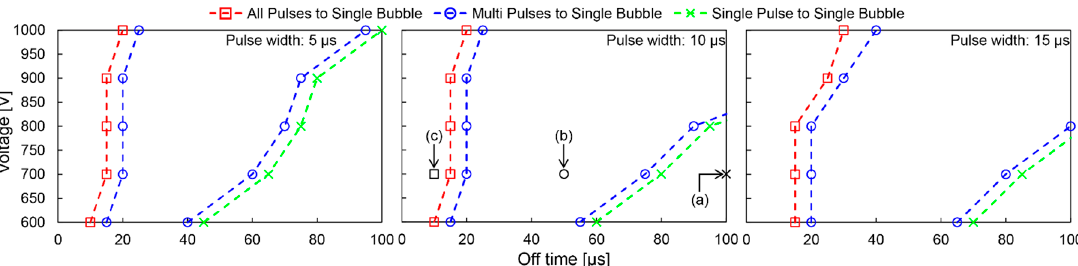
Figure 4. Results of the classification of micro-plasma bubble generation modes by pulse conditions. There are three generation modes: APSB, MPSB, and SPSB, and their boundaries are plotted and connected by dashed lines. Panels ( a – c ) in the figure correspond to Figure 3.